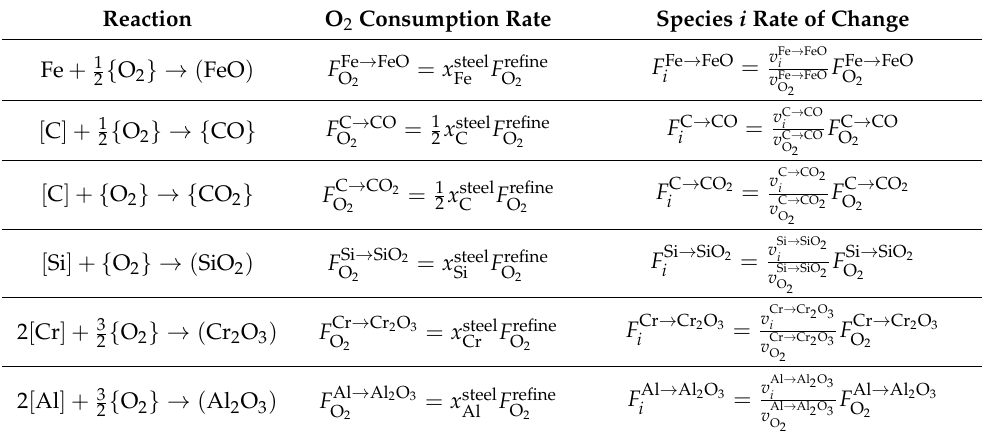
Table A1. Oxygen consumption and species rate of change for each steel reaction with oxygen. F denotes molar rates of change, v denotes stoichiometric coefficients and x denotes mass fractions. Reaction